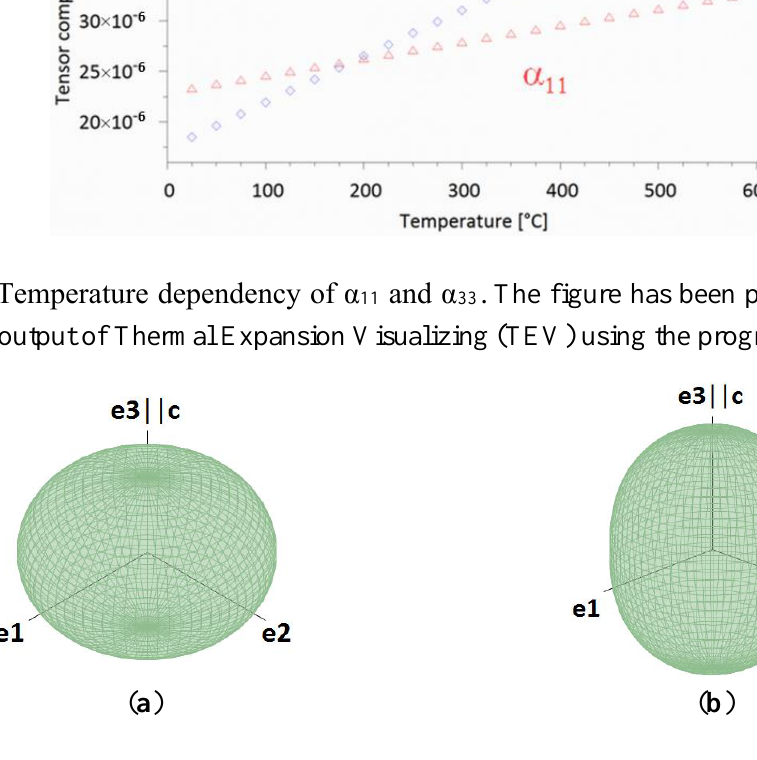
Figure 3. Representation surfaces for the tensor of thermal expansion at ( a ) 25 °C; and ( b ) 600 °C.